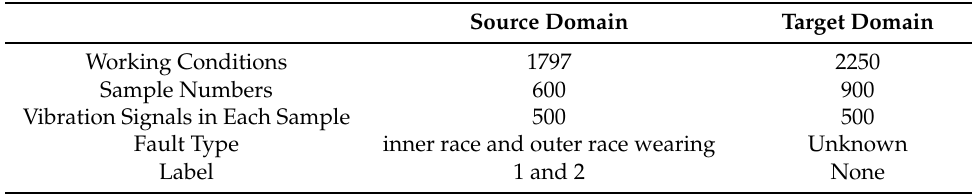
Table 1. Data of Source and Target Domains.